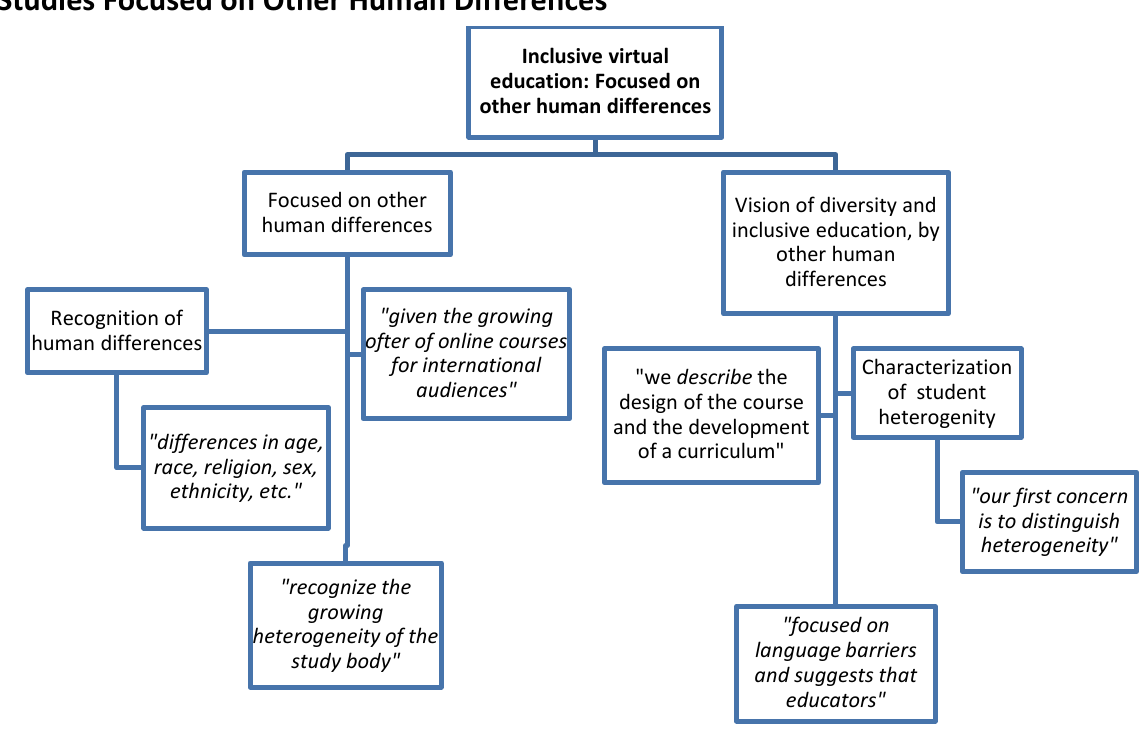
Figure 3 . Focused on other human differences. This mind map illustrates the subcategory and its properties. Regarding the properties, some of the text is framed in quotation marks and italics, which correspond to brief textual quotations of some of the articles